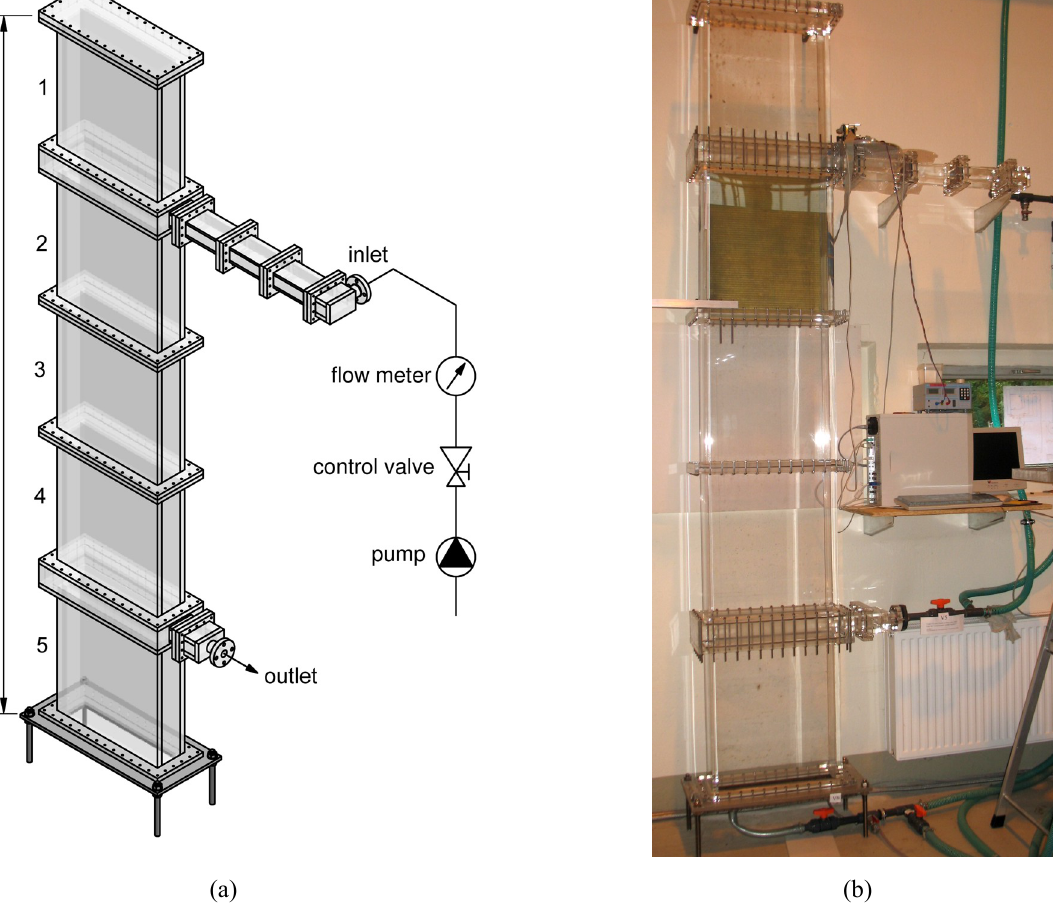
Figure 6 . Schematic diagram (a) and photograph (b) of the test facility used in the buoyancy-driven flow